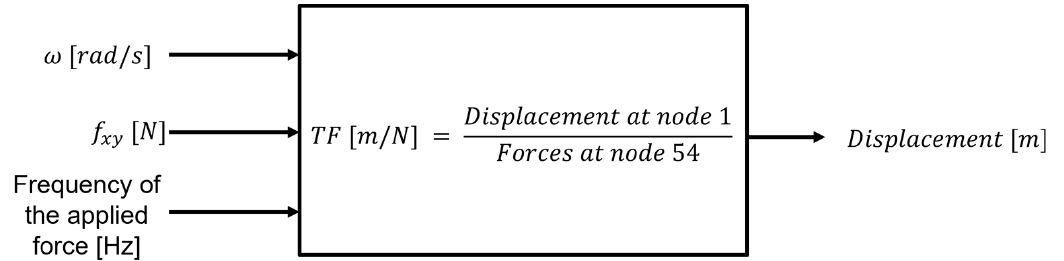
Figure 13. Transfer function plotted at different (cid:2033) (zoom to the region of interest).